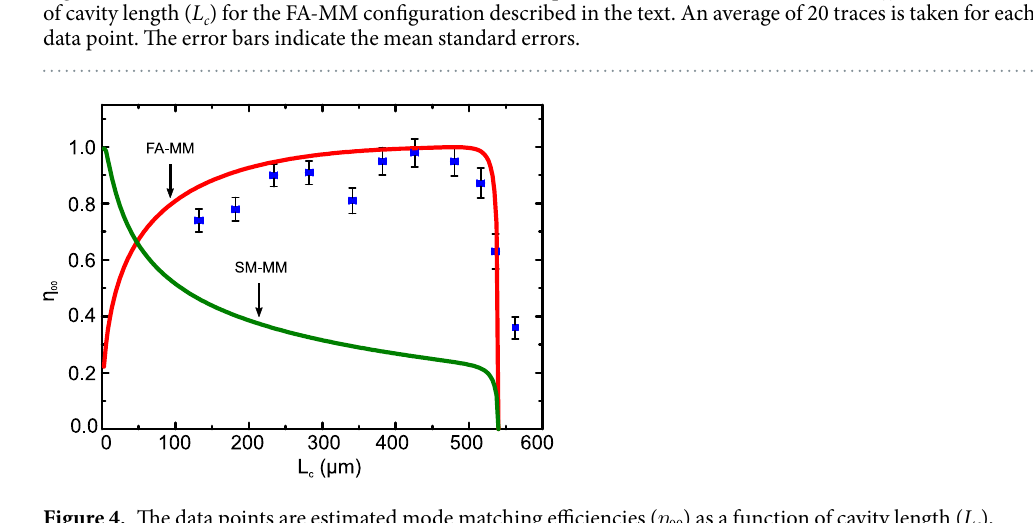
Figure 4. The data points are estimated mode matching efficiencies ( η 00 ) as a function of cavity length ( L c ), calculated by using Eq. (3), for FA-MM configuration. The error bars indicate the mean standard errors. Solid lines are numerical simulations for the FA-MM and SM-MM